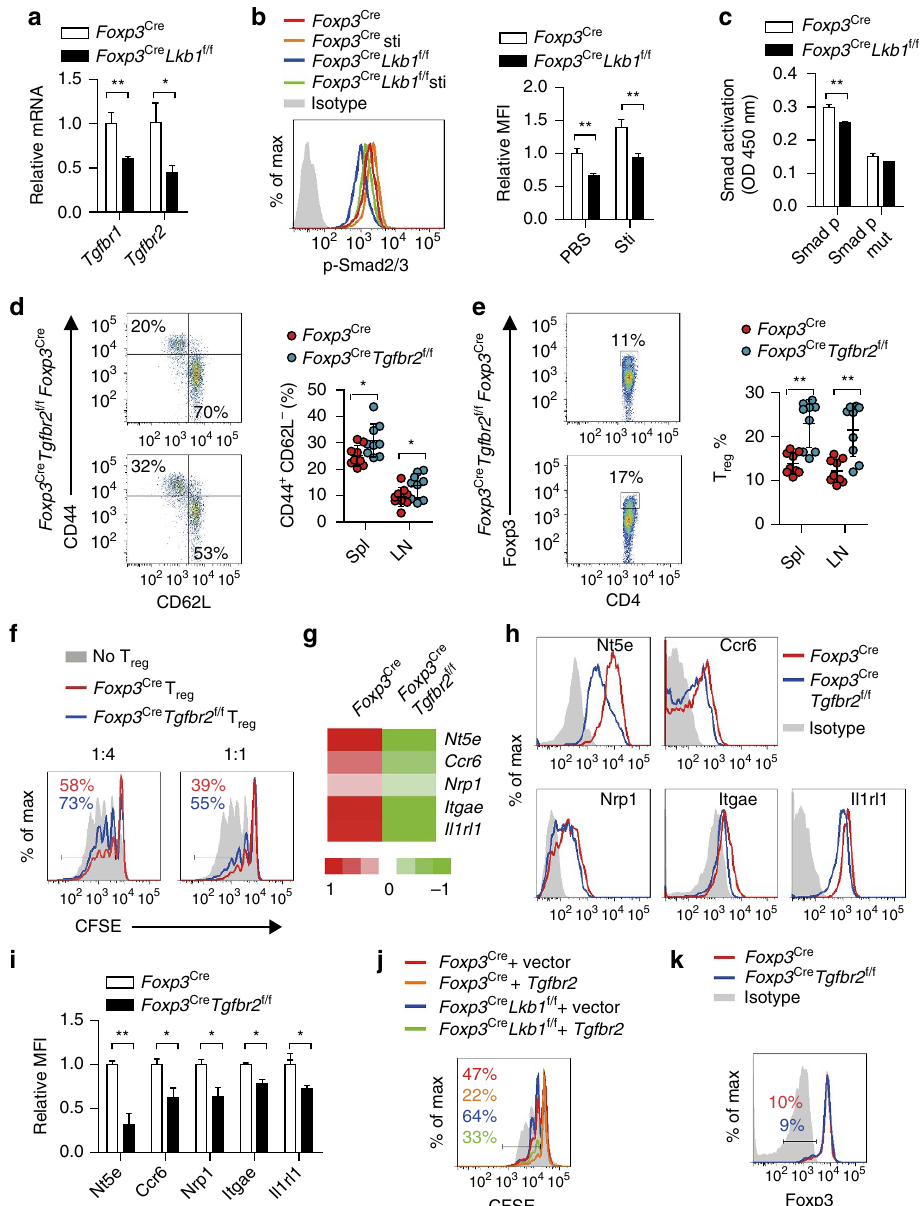
Figure 8 | TGF- b signalling is involved in Lkb1-implemented T reg cell suppressor function. ( a ) Tgfbr1 and Tgfbr2 mRNA expression in Foxp3 Cre and Foxp3 Cre Lkb1 f/f T reg cells by real-time PCR ( n ¼ 3). ( b ) Intracellular expression of phosphorylated Smad2/3 in T reg cells from Foxp3 Cre and Foxp3 Cre Lkb1 f/f mice, with or without TGF- b stimulation ( n ¼ 3). ( c ) Binding capacity of Smad2/3 to recognized DNA sequences in nuclear lysates extracted from T reg cells from Foxp3 Cre and Foxp3 Cre Lkb1 f/f mice. ( d ) CD44 and CD62L expression on CD4 þ Foxp3 (cid:2) T cells from 6-week-old Foxp3 Cre and Foxp3 Cre Tgfbr2 f/f mice ( n ¼ 6–11). ( e ) Foxp3 expression in CD4 þ Tcells from 6-week-old Foxp3 Cre and Foxp3 Cre Tgfbr2 f/f mice ( n ¼ 6–11). ( f ) Suppression of proliferation of T n cells labelled with CFSE by different ratios of CD4 þ YFP þ T reg cells from Foxp3 Cre and Foxp3 Cre Tgfbr2 f/f mice. The experiment was repeated three times. ( g ) Some genes differentially expressed between CD4 þ YFP þ T reg cells from Foxp3 Cre and Foxp3 Cre Tgfbr2 f/f T reg cells determined by transcriptional profiling. Fold difference means fold change of gene expression levels in T reg cells from Foxp3 Cre Tgfbr2 f/f mice compared with that from Foxp3 Cre mice. ( h , i ) Expression of indicated proteins on splenic T reg cells from Foxp3 Cre and Foxp3 Cre Tgfbr2 f/f mice ( n ¼ 3). ( j ) Suppression of proliferation of T n cells labelled with CFSE by different ratios of CD4 þ YFP þ T reg cells from Foxp3 Cre and Foxp3 Cre Lkb1 f/f mice that were transduced with retrovirus carrying TGF- b R2 or control vector. ( k ) Foxp3 expression in CD4 þ YFP þ T reg cells doubly sorted from Foxp3 Cre and Foxp3 Cre Tgfbr2 f/f mice and transferred together with T n cells into Rag1 (cid:2) / (cid:2) mice for 3 weeks. Two-way analysis of variance (ANOVA) was used for statistical analyses in ( a , b , c,d , e , i ) (* P o 0.05, ** P o 0.01); error bars represent s.d.; all data are representative of at least two independent experiments.